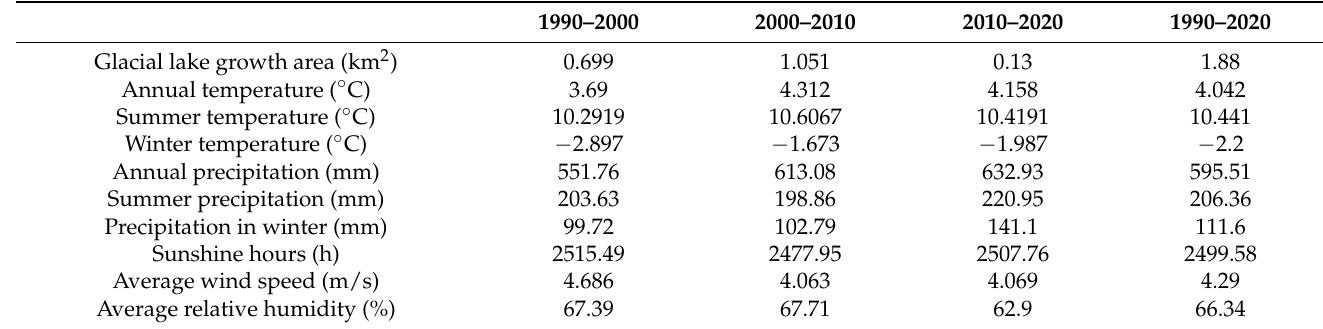
Table 5. Thirty-year annual change in Nyalam County.